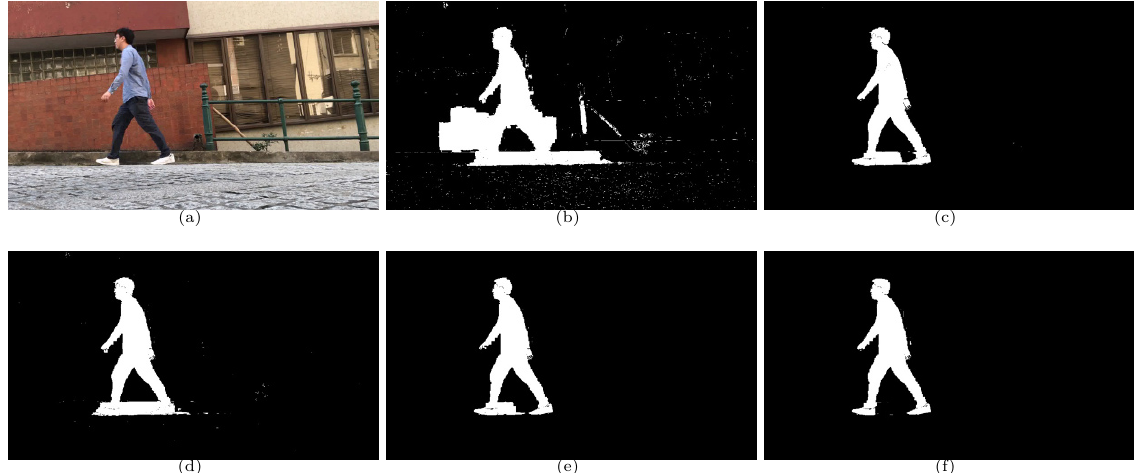
Fig. 9 (a) Input frame. (b) Background cut in RGB space result with a low variance ( σ s r = (5 / 255) 2 ) Gaussian model. (c) Background cut in RGB space result with a larger variance ( σ s r = (20 / 255) 2 ). (d) Background cut in CIE-Lab space result with σ L = σ a = σ b = (5 / 255) 2 . (e) Background cut in CIE-Lab space result with larger variance in the L channel ( σ L = 5 ∗ (5 / 255) 2 ). (f) Result of our method ( σ pe = (10 / 255) 2 ,σ pa = 10 ∗ (10 / 255) 2